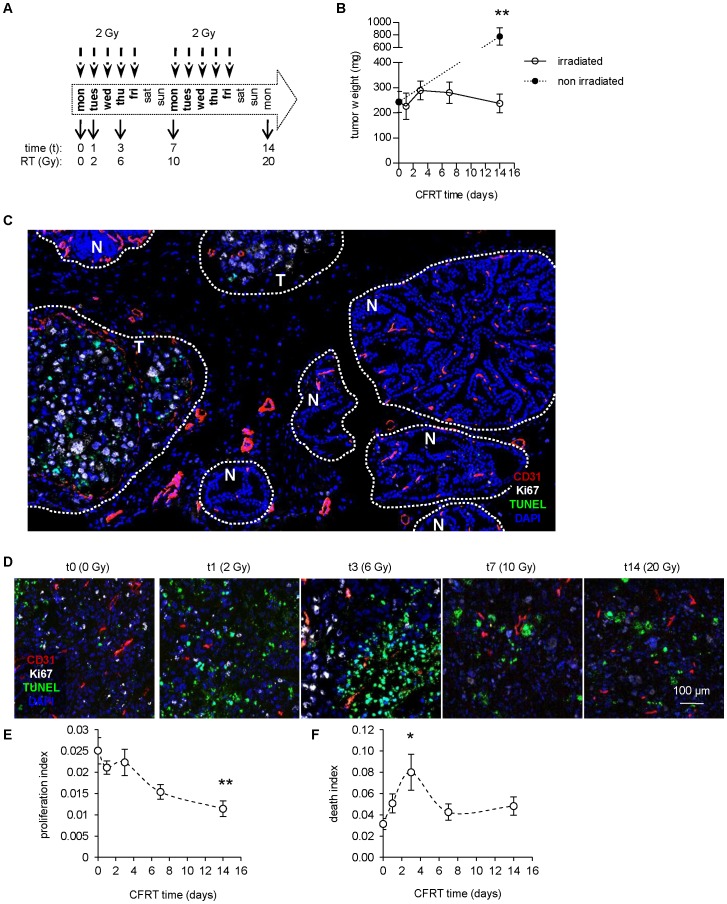
Control of prostate tumor growth by fractionated irradiation.(A) Scheme of the conventional fractionated radiation therapy (CFRT) protocol used for treatment of established prostate tumors. (B) Weight of dissected tumors after the indicated time of CFRT. Values  =  average of n≥6 ± sem. Statistical comparison vs. t14 irradiated. (C) Example of a tumor treated for one week, showing TUNEL+ tumor cells ("T") and normal adjacent tissues ("N") mainly TUNEL-. Tumor and normal tissues were identified with DAPI based on nuclei morphology, size, staining intensity and spatial organization of cells. (D) Pseudo-confocal images of tumors during CFRT, stained for Ki-67/TUNEL/CD31. (E,F) Image quantification of cell proliferation (Ki-67 index, E) and cell death (TUNEL index, F). Statistical comparisons vs. t0.